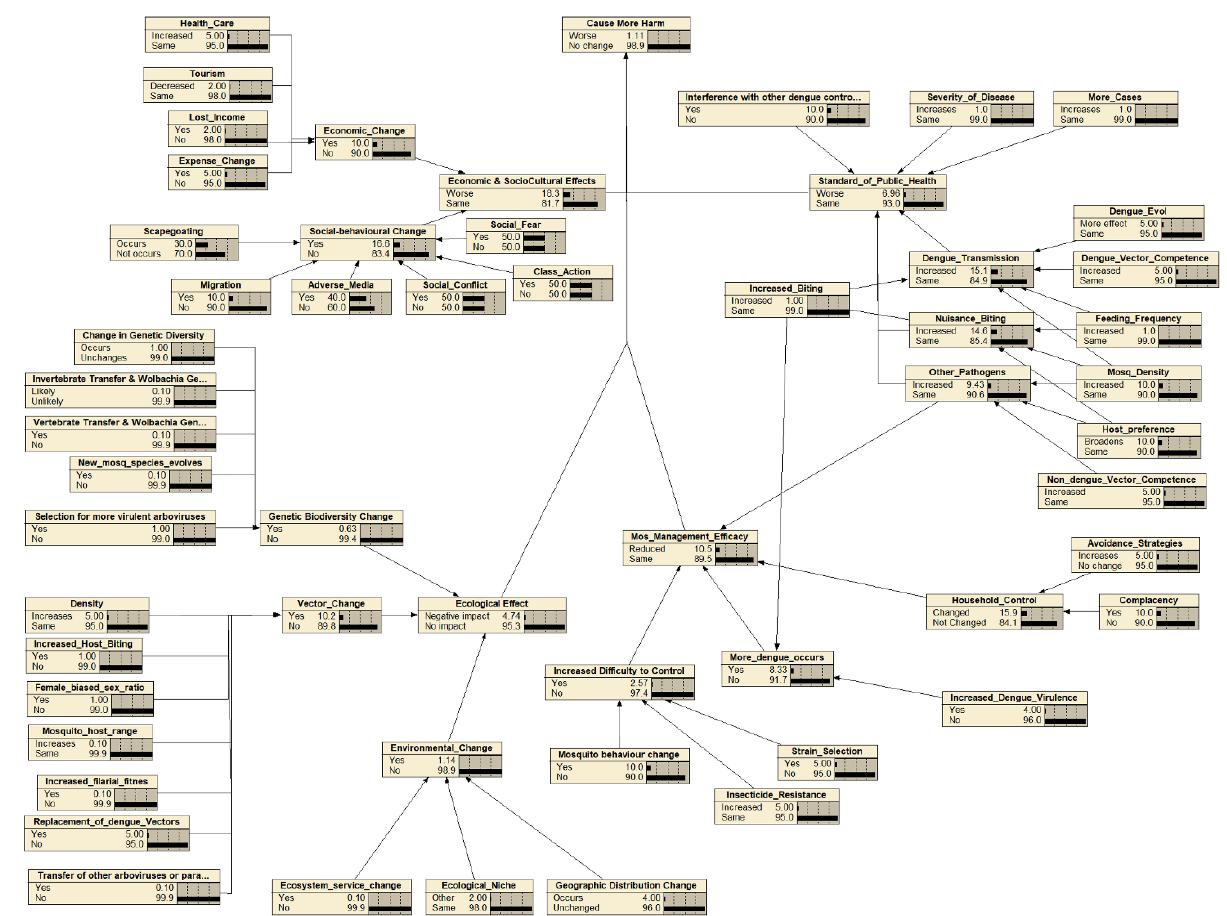
Figure 2. The Bayesian belief network for the endpoint “cause more harm”. Each node (box) represents probability of hazards that might occur within the next 30 years as the result of the release of Wolbachia -infected Ae. aegypti .